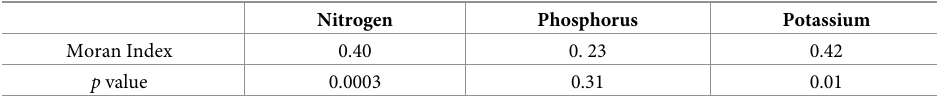
Table 4. Moran index for the for maize fields in a smallholder landscape in Western